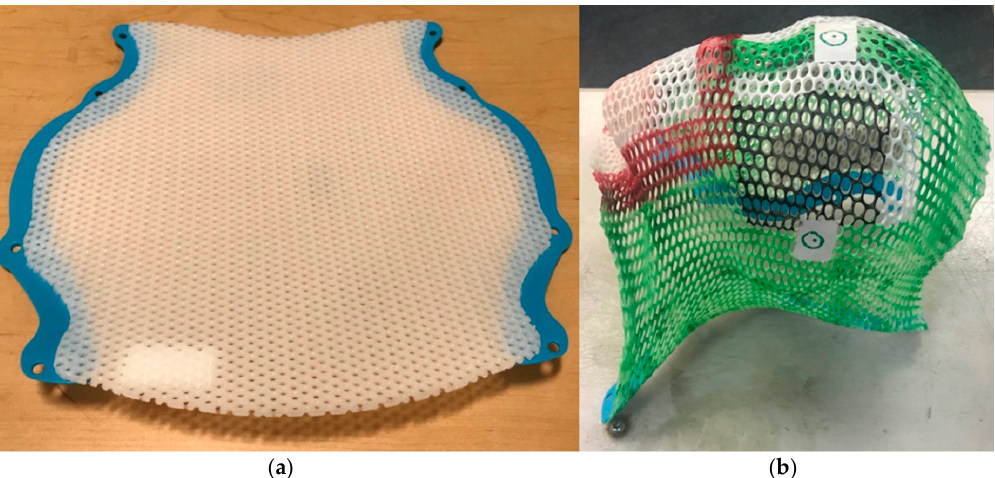
Figure 3. Immobilization device for RT. To create an immobilization device for each patient undergoing RT to treat a brain tumor, a hard sheet of plastic mesh ( a ) is warmed in a water bath before stretching it to conform to the contours of the head. The mesh then cools and hardens, forming a customized mask ( b ) that can be fixed to the table on which the patient lies during daily radiation